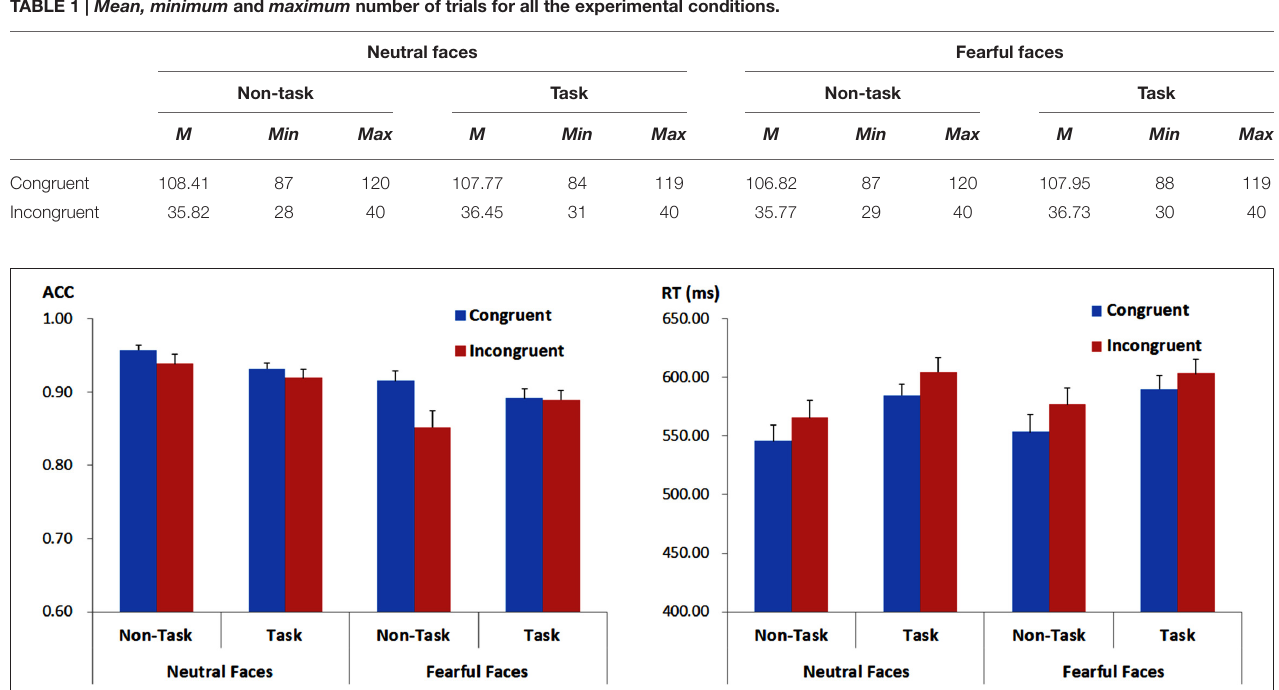
Frontiers in Human Neuroscience |